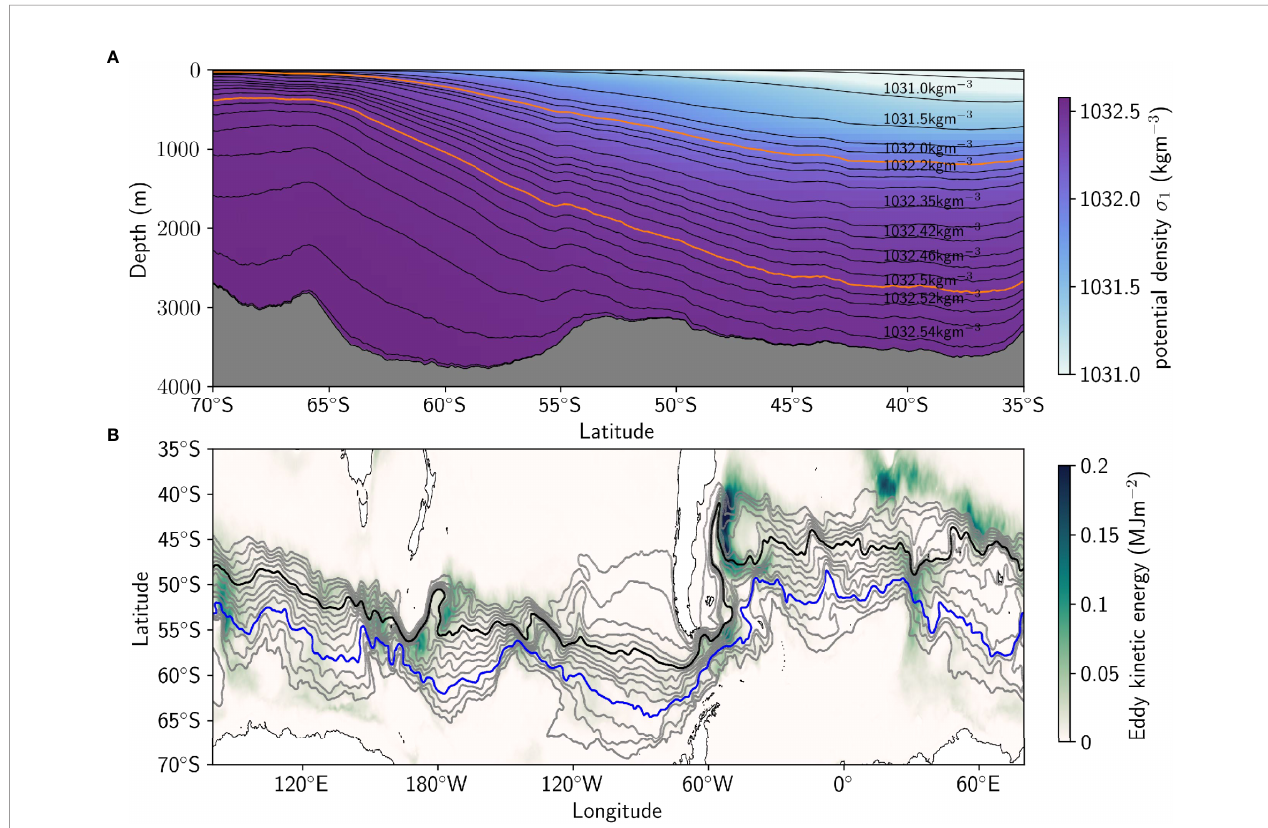
FIGURE 4 | (A) Zonal mean isopycnal depths demonstrating the spacing of chosen s 1 density bins (central value stated), which divide the ocean into 100-200m thick layers. Black lines indicate interfaces between the isopycnal layers. A subset of isopycnal layers are labelled with their density. The upwelling density range 1032.2 < s 1 < 1032.5 kg m -3 is highlighted in orange. (B) Selected circumpolar SSH contours (grey) with depth integrated eddy kinetic energy (green background). Every second SSH contour is shown, here spaced 0.1 m apart, with the -1.2 m SSH contour highlighted in blue and the -0.6 m SSH contour in